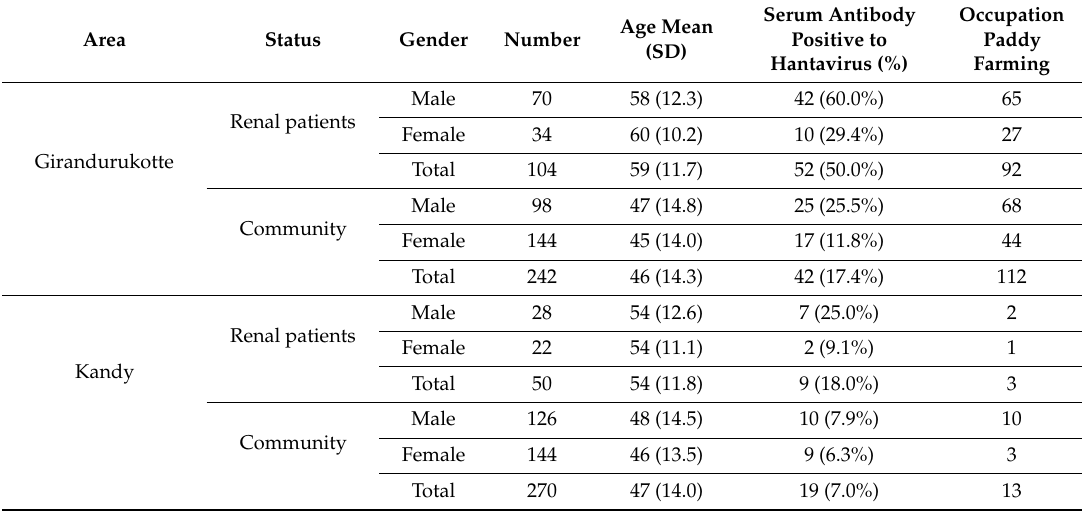
Table 1. Demographic characteristics of the study